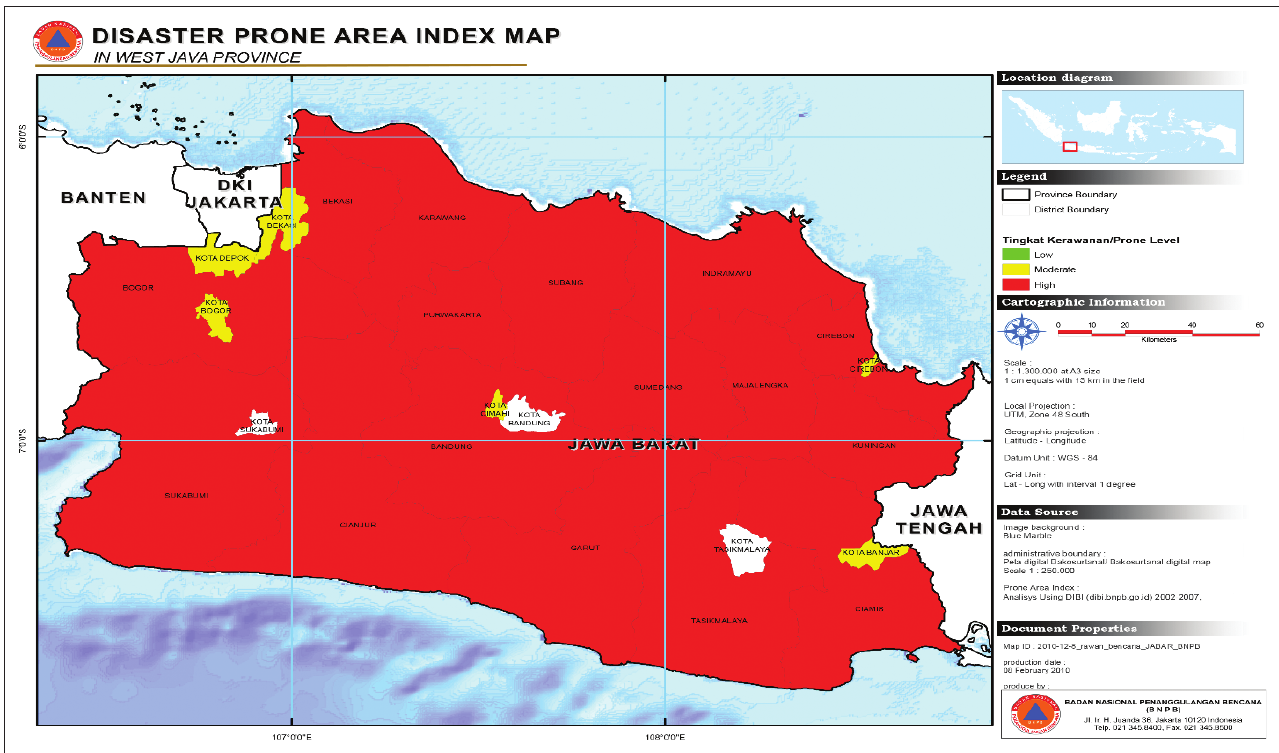
FIGURE 2: Disaster prone area index map in West Java